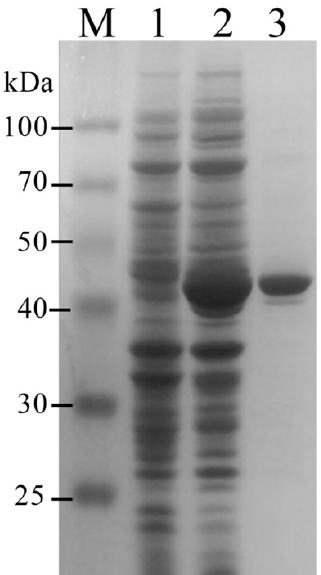
Table 1. Pb LeuDH activity toward L-leucine before and after purification.